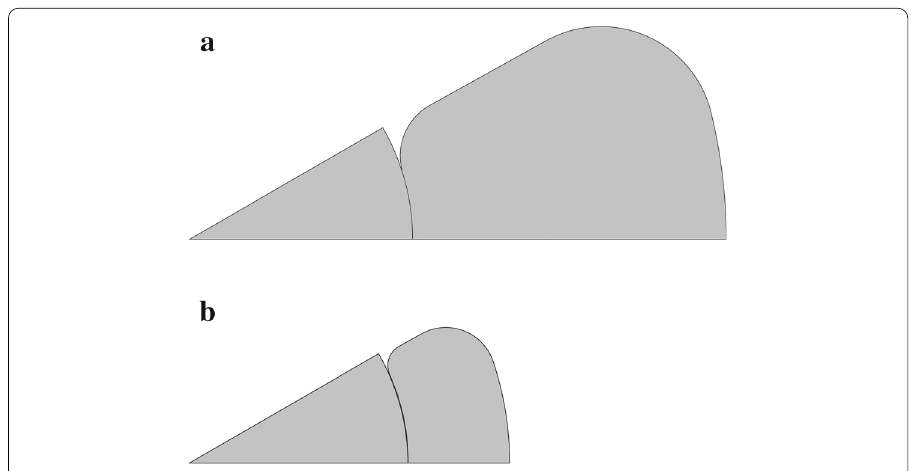
Fig. 13 Optimal cross sections obtained with different objectives and constraints. a Shape obtained by minimizing the stress concentration and constraining the limit load and bending stiffness. b Shape resulting from area minimization with unconstrained limit load, but given axial load at plastification F p